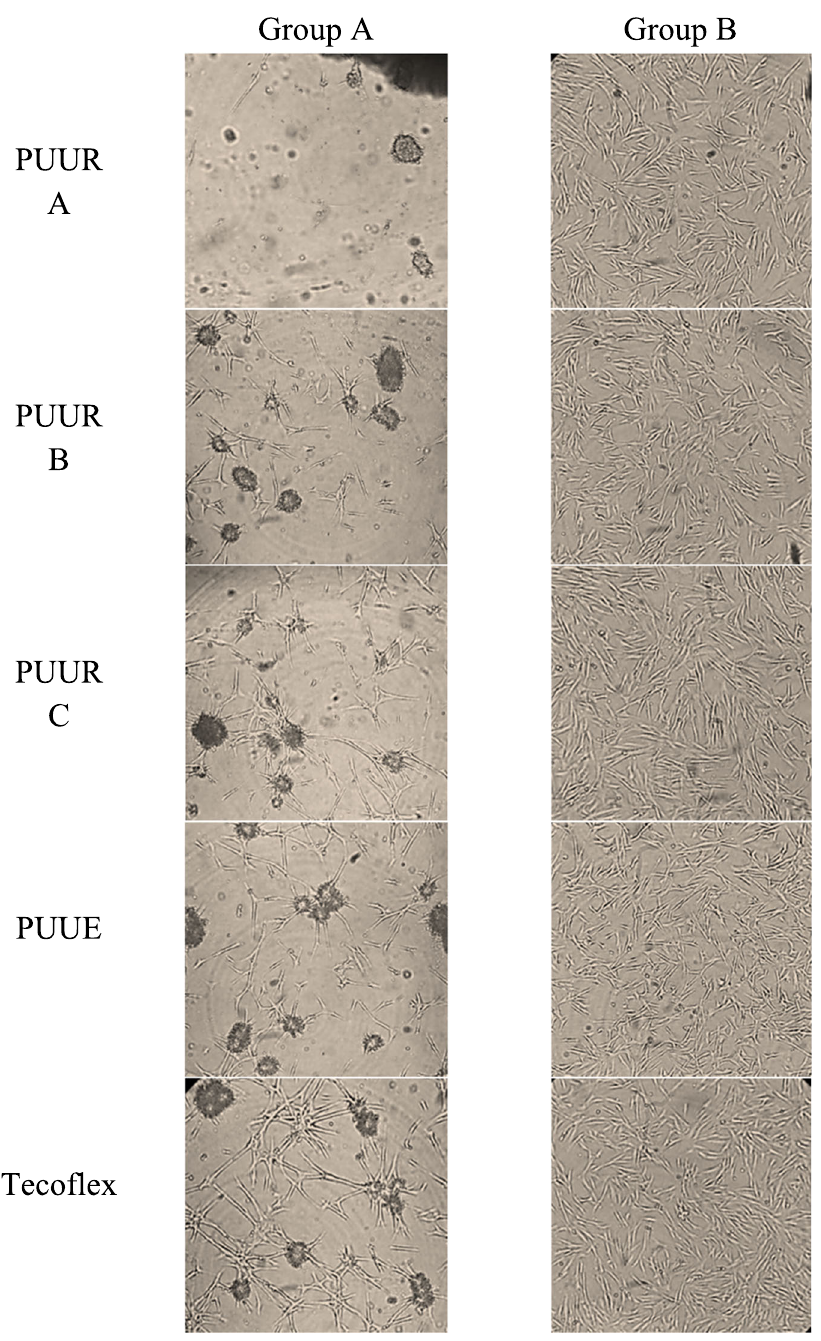
Fig. 4 Morphology of hFB cells cultured for 24 h on unwashed (group A) and washed (group B) of electrospun poly(urea- urethane) membranes (PUUR A, PUUR B, PUUR C, and PUUE) and Teco fl